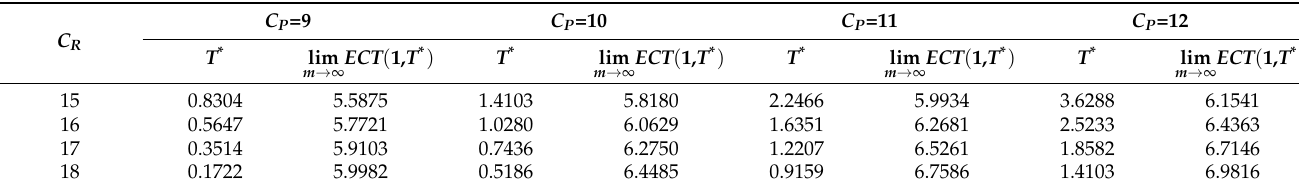
Table 4. The impacts of C R and C P on the optimal